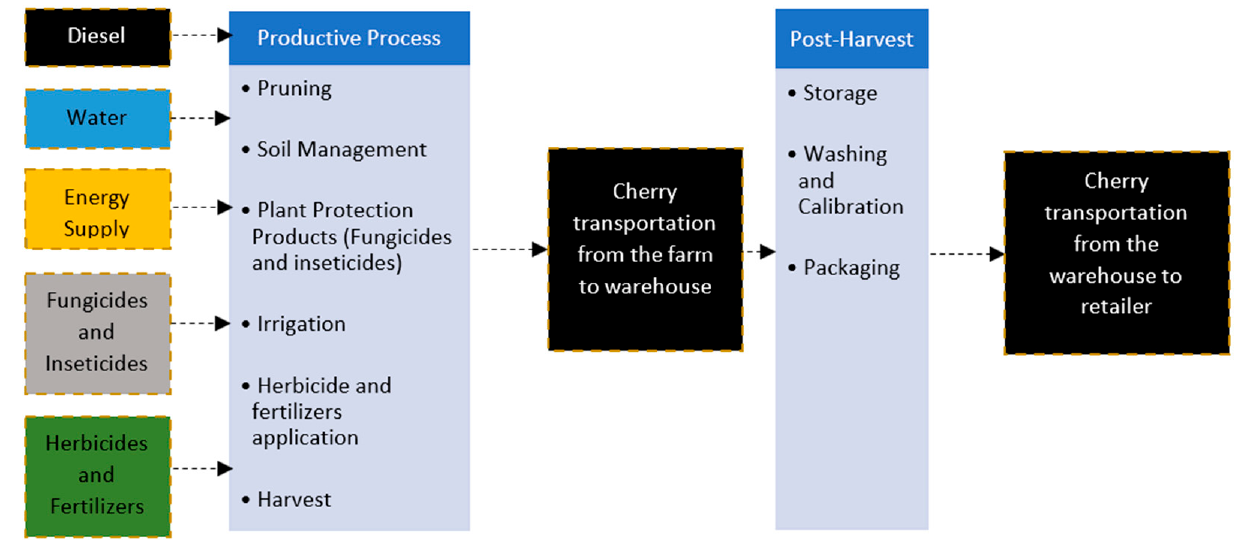
Figure 1. System Boundaries of cherries LCA.